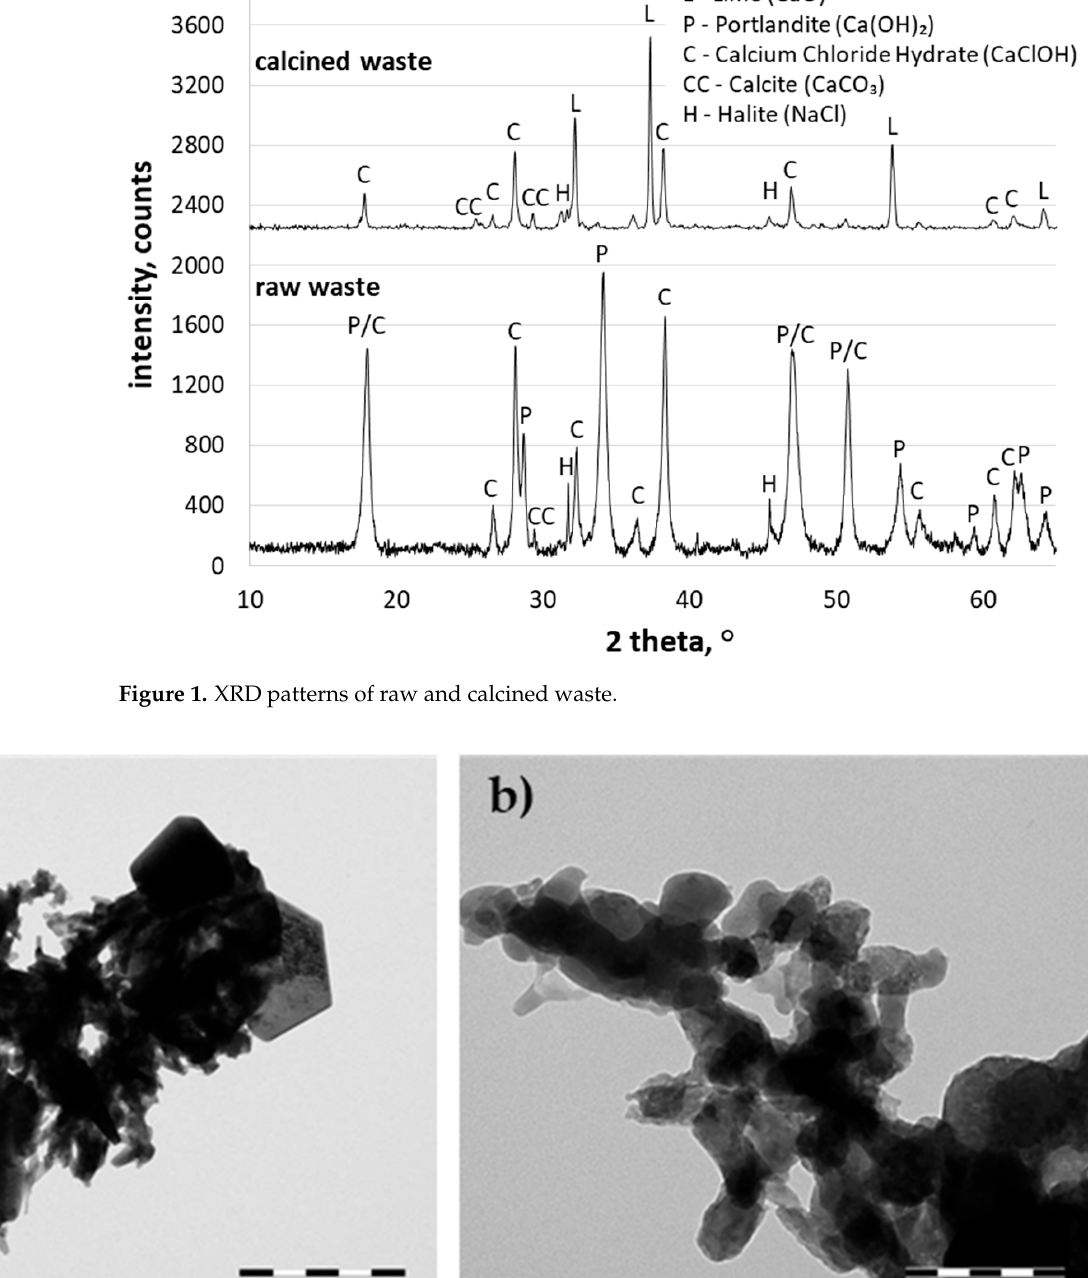
Figure 2. TEM microphotograph of raw waste: ( a ) hexagonal plate of portlandite together with fine grains of other compounds; ( b ) detailed view of fine grains of the waste.